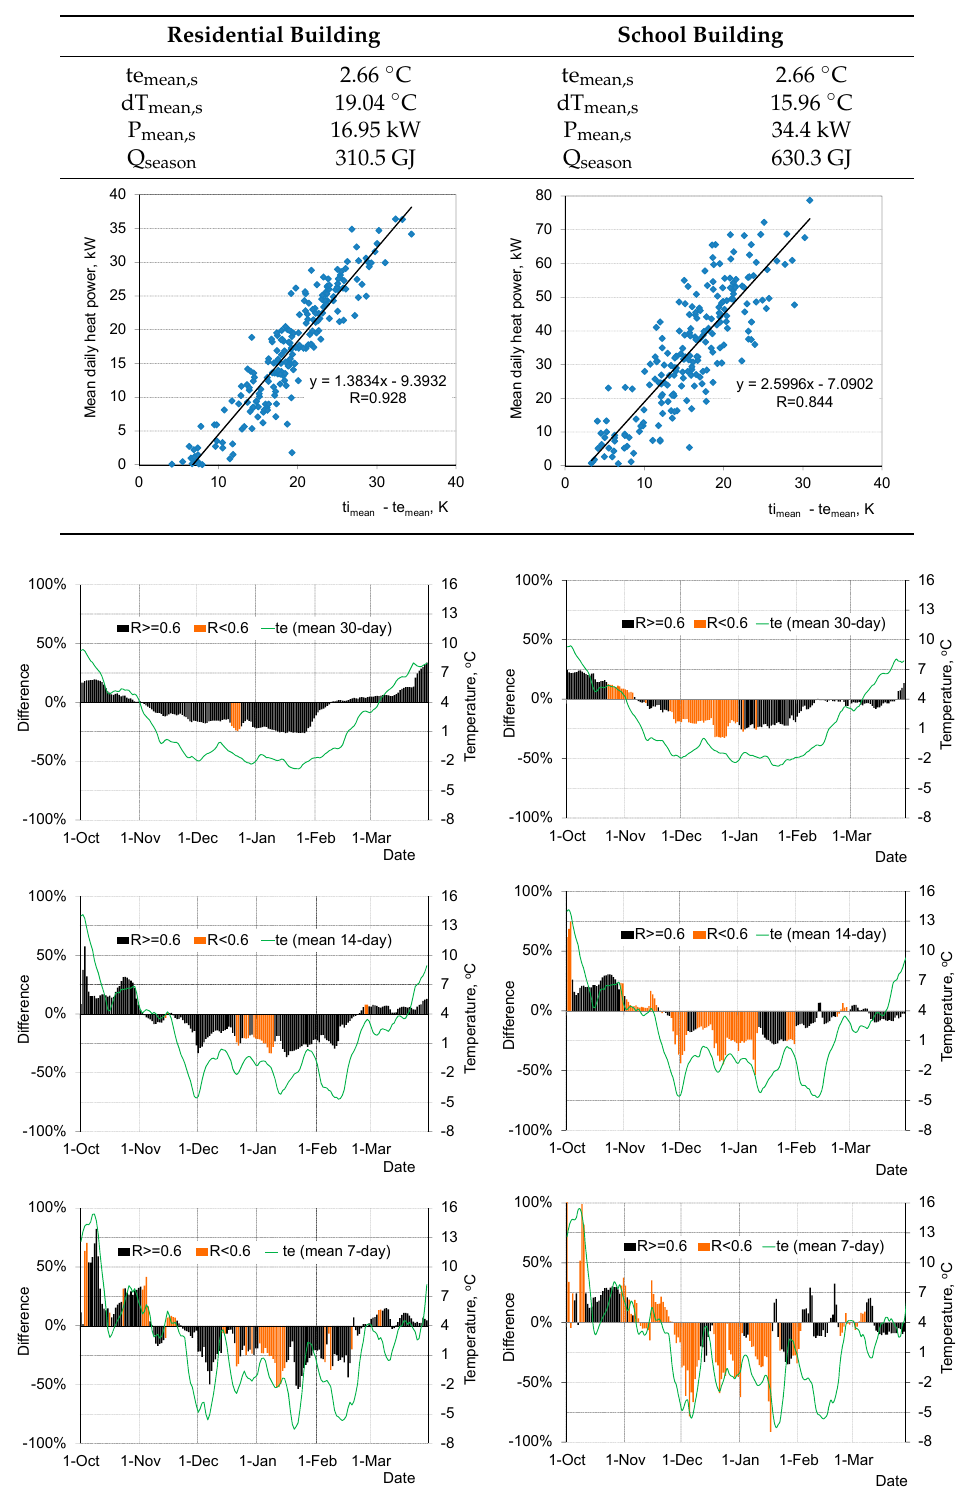
Figure 6. Differences in seasonal heat demand obtained from simulation and from short measurement periods for the residential building (on the left) and for the school building (on the